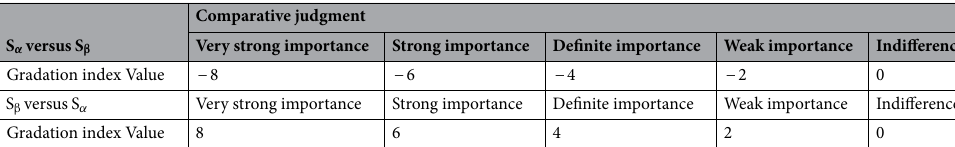
Table 2. Integer-valued cluster important judgment designating the